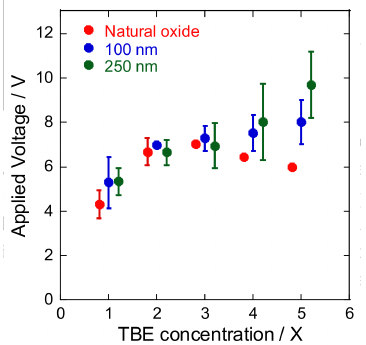
Figure 4. Average voltage applied at the time of dielectric breakdown under different oxide layer thicknesses and buffer concentrations ( n = 3). At the same concentration of TBE buffer, three plots and error bars depicted in red, blue, and green were intentionally shifted, so as to be easily